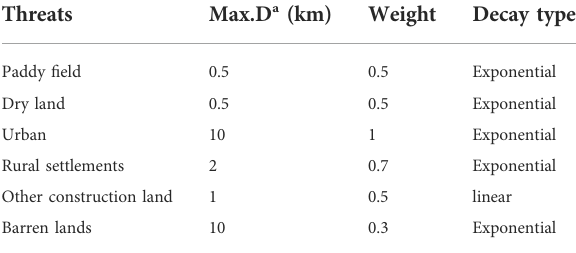
TABLE 4 Weights for threat factors of the study